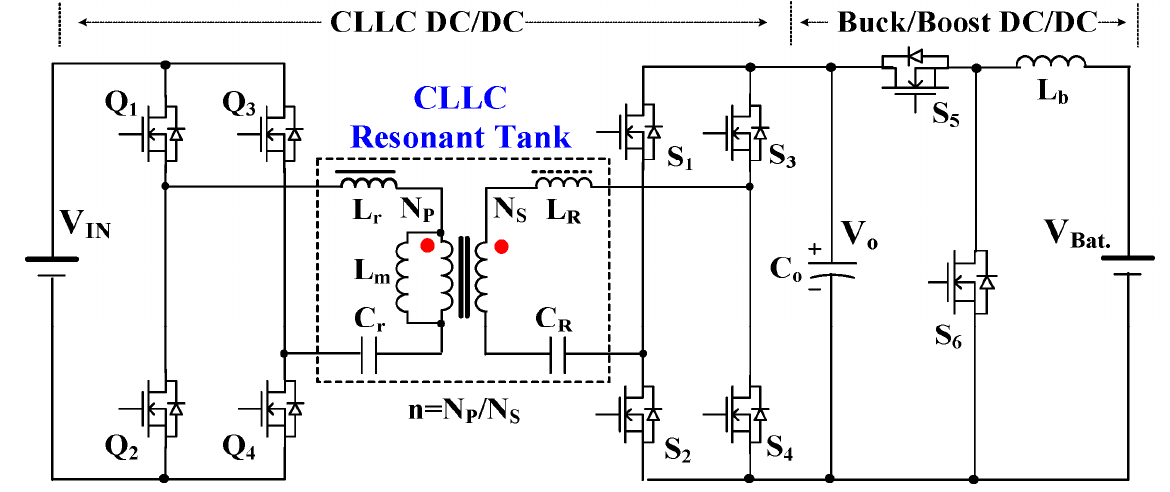
Figure 5. Conventional two-stage bidirectional LLC converter